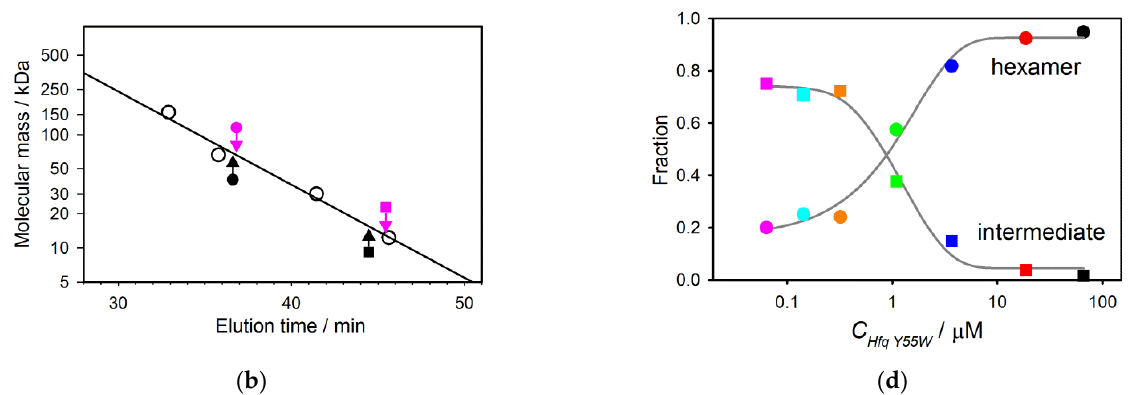
Figure 6. The size-exclusion chromatography of Hfq Y55W at 1.6 M GuHCl: ( a ) The set of standardized elution profiles of Hfq Y55W at various concentrations of the protein loaded (67 μ M is shown in black, 18.9 μ M—in red, 3.7 μ M—in dark blue, 1.1 μ M—in green, 0.33 μ M—in yellow, 0.15 μ M—in cyan, and 0.064 μ M—in pink); ( b ) The dependence of the elution time on the protein molecular mass (the chromatographic column calibration); proteins used for calibration are aldolase (158 kDa), bovine serum albumin (66 kDa), bovine carbonic anhydrase B (29 kDa), cytochrome c (12.3 kDa). The arrows indicate the elution times of the respective peaks at the highest (black) and the lowest (pink) concentration of the protein loaded; ( c ) The dependence of the elution peak time on the protein concentration loaded ( ◯ —initial peak, ◻ —peak of the dissociated intermediate; the color coding is the same); ( d ) The dependence of the protein state populations (determined as the areas of corresponding elution peaks) on the protein concentration loaded ( ◯ —hexamer, ◻ — dissociated intermediate; color coding is the same).